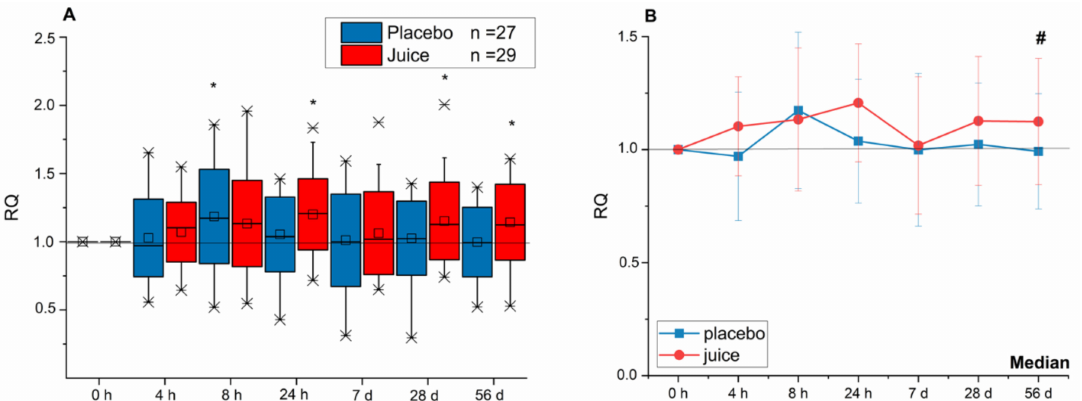
Figure 3. Modulation of NQO-1 gene transcription after 4-, 8-, 24-h and 7-, 28-, 56-day intake of red multi-fruit juice (juice, n = 29) or placebo (placebo, n = 27). ( A ) The relative transcript levels were normalized to the means of ACTB and GAPDH and the negative control (transcript levels at time point 0 h; RQ). ( B ) Line graphs represent the median values of relative transcript levels (RQ) ± SD. Significance compared to the control is calculated by Kruskal–Wallis test with * = p < 0.05; significances relative to placebo group with # = p <